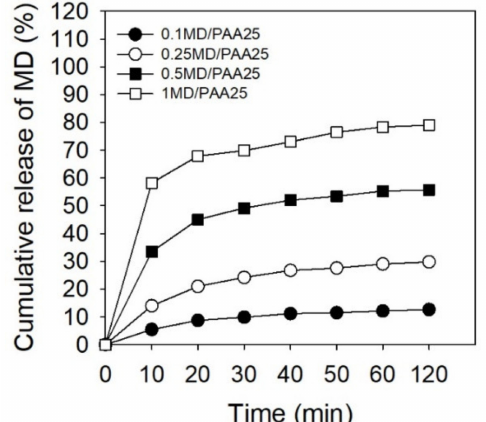
Figure 10. Cumulative release of metronidazole from MD / PAA hydrogel films with di ff erent content of